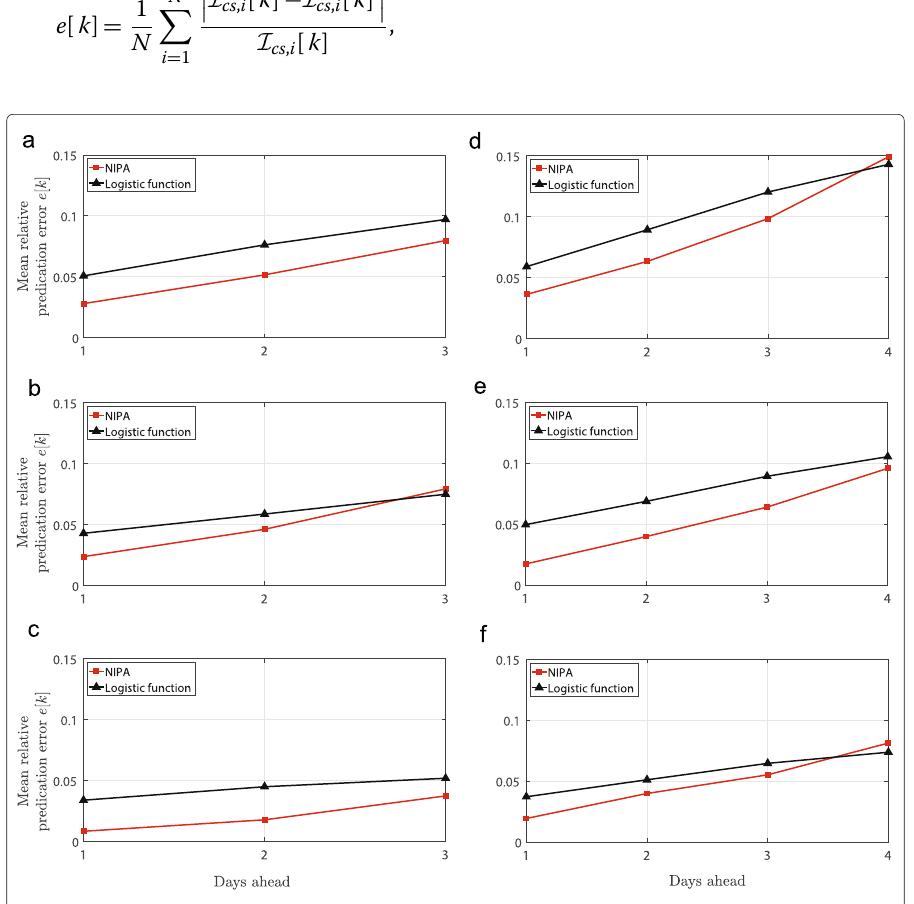
Fig. 3 Prediction error versus prediction time . The prediction accuracy of NIPA and logistic regression to forecast the COVID-19 outbreak in Hubei. Each subfigure is obtained by omitting a number of days prior to February r and subsequently predicting the same number of days ahead in time. The subfigures of the three rows ( a , d ), ( b , e ) and ( c , f ) correspond to February r = 10, r = 12 and r = 14, respectively. The subfigures of the two columns ( a , b , c ) and ( d , e , f ) correspond to m = 3 and m = 4 omitted days before February r ,